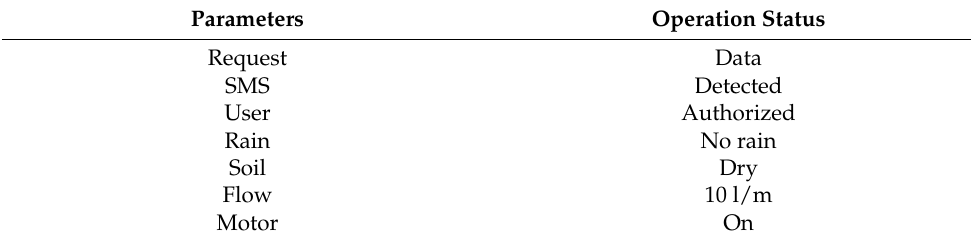
Table 6. The system detects a data request from the